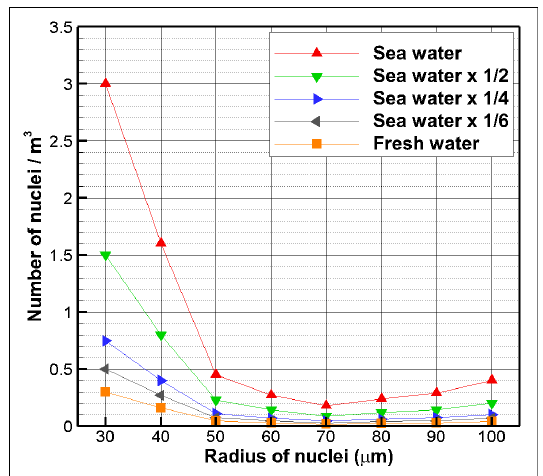
Figure 25. The number concentration density for each nuclei size.